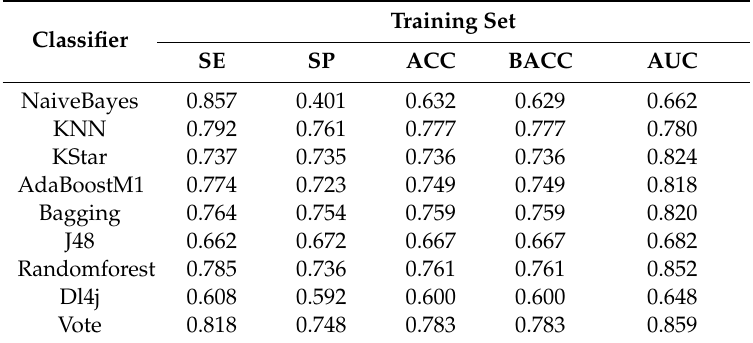
Table 1. Performances of nine models developed based on different machine learning algorithms, in terms of five different indices.